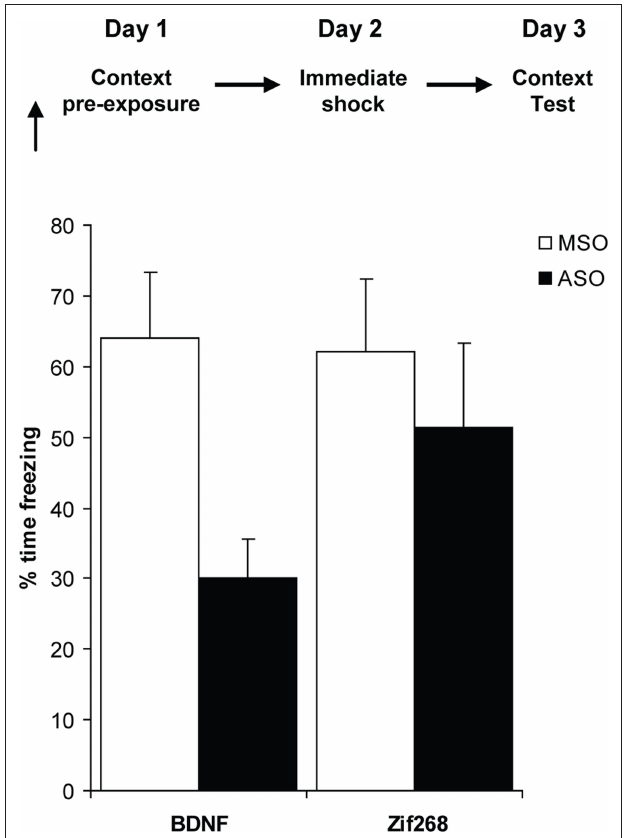
Figure 3 | Acquisition of the contextual representation requires BDNF, but not Zif268. Knockdown of BDNF, but not Zif268, in the dorsal hippocampus during context pre-exposure impaired the subsequent ability of rats to retrieve the memory of the context in order to associate it with the footshock, and hence BDNF knockdown rats froze significantly less at the context fear memory test ( n = 5–6 per group). Data presented as mean + ( Figure 5B ). Under these conditions, Zif268 ASO infusion prior to a 2-min context re-exposure did impair the reconsolidation of the